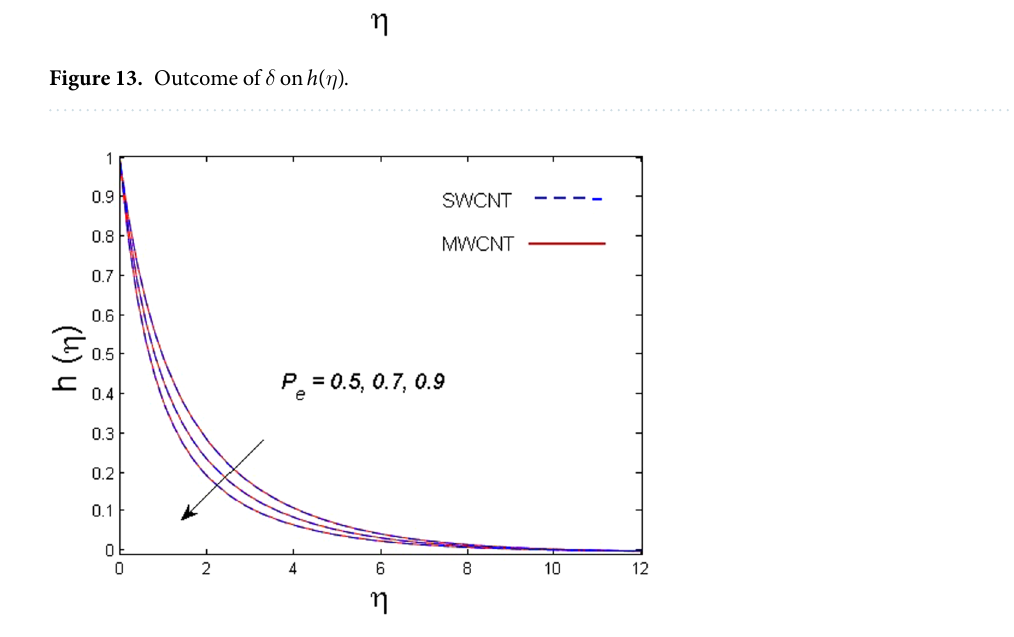
Figure 14. Outcome of P e on η h ( )